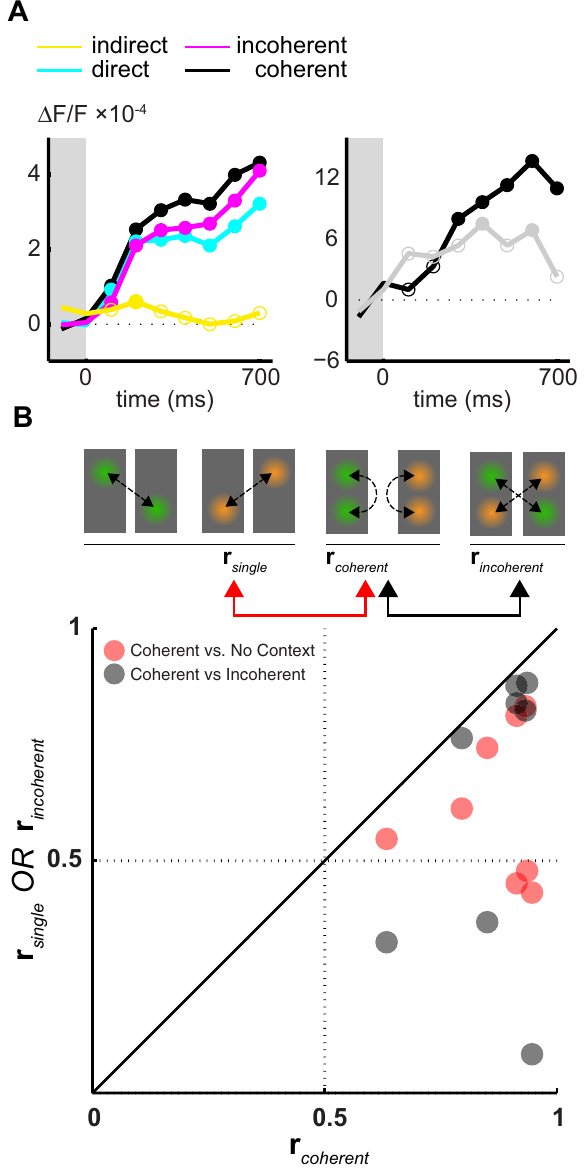
Figure 5. Time-course of contextual interactions. ( A ) The temporal evolution of activity in response to indirect ( yellow ), direct ( cyan ), coherent ( black ) and incoherent ( magenta ) stimulation ( left panel). Average activity within the regions of interest (depicted in Figure 3) is used. For each temporal window the median across experiments and movies is presented. Median values that are statistically different (sign-rank test, alpha = 0.05) from zero are depicted with filled circles. The pair-wise difference of amplitudes between coherent and single conditions ( black line) as well as between coherent and incoherent ( gray line) conditions is shown in the right panel. ( B ) The similarity between the time-courses of activity recorded at two distant regions of interest is evaluated for each movie separately under different conditions (2 dots per experiment). r measures the correlation coherent between two time-courses of activity evoked by the simultaneous presentation of two local movie-patches. r and r were incoherent single computed using the activity evoked by exactly the same input however presented at different conditions (see icons and arrows). The scatter plot depicts the comparison of r to r and r coherent single incoherent